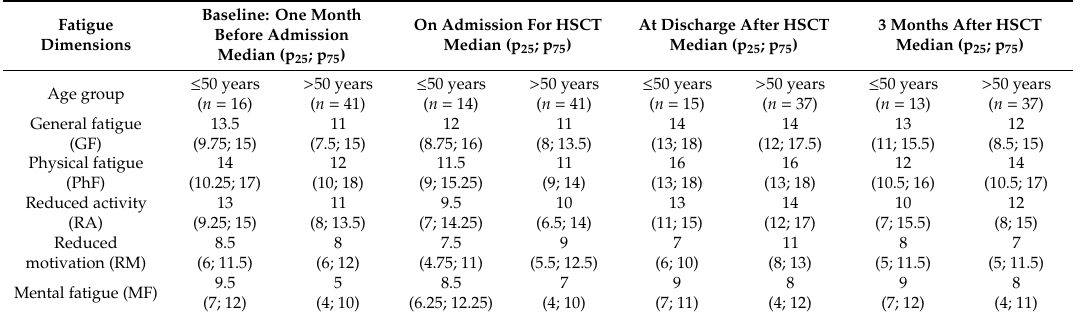
Table 3. The trajectory of fatigue levels related to age among patients undergoing